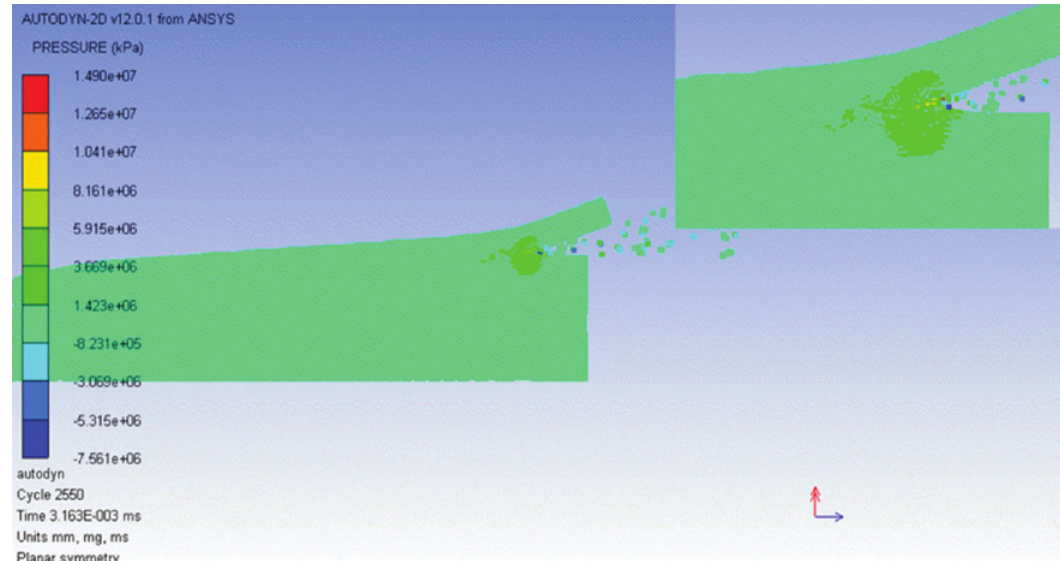
Figure 5: The pressure distribution of combination in the simulation.